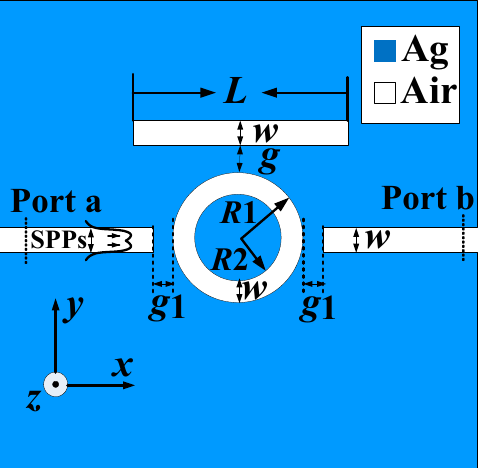
Figure 1. Schematic of the metal-insulator-metal (MIM) plasmonic waveguide system for Fano resonance.